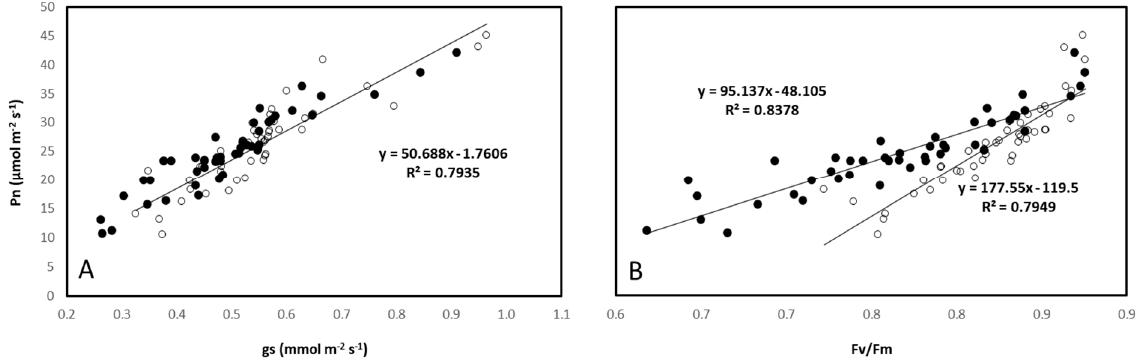
Figure 8. Leaf net photosynthetic rate (P n ) as a function of stomatal conductance (g s ; ( A )) and chlo- rophyll fluorescence (F v /F m ; ( B )) in five milk thistle ecotypes (‘Ahvaz’, ‘Budakalazi’, ‘Khomin’, ‘Khoram Abad’, and ‘Sari’), cultivated under application of chitosan or TiO 2 treatments (bulk, na-